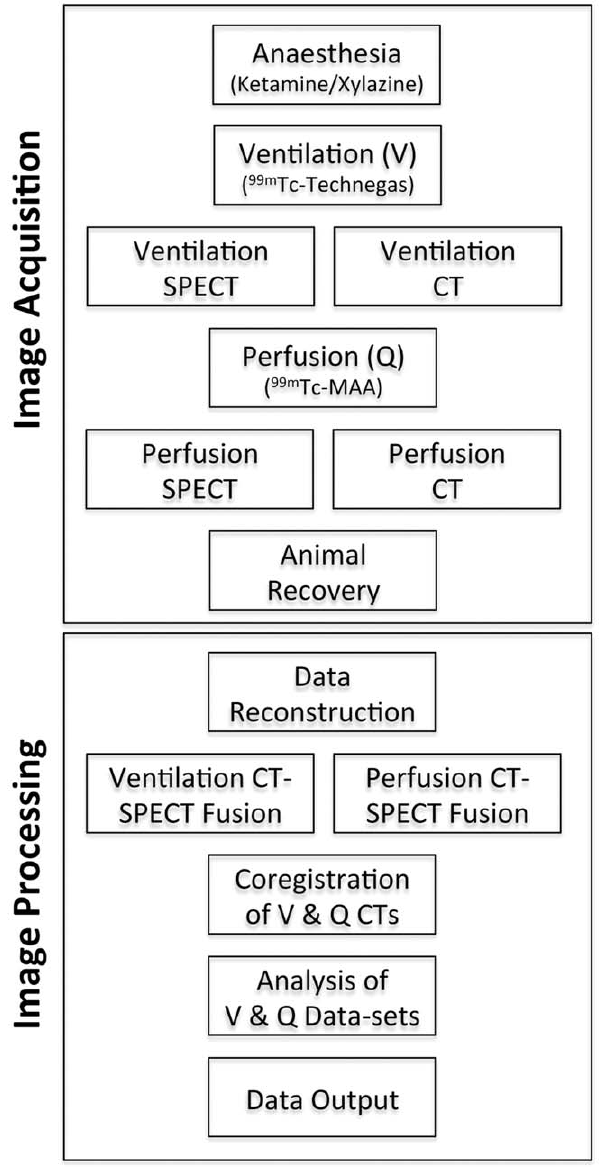
Figure 1. Simplified representation of the methodology used in image acquisition and processing to provide the final V/Q data sets.